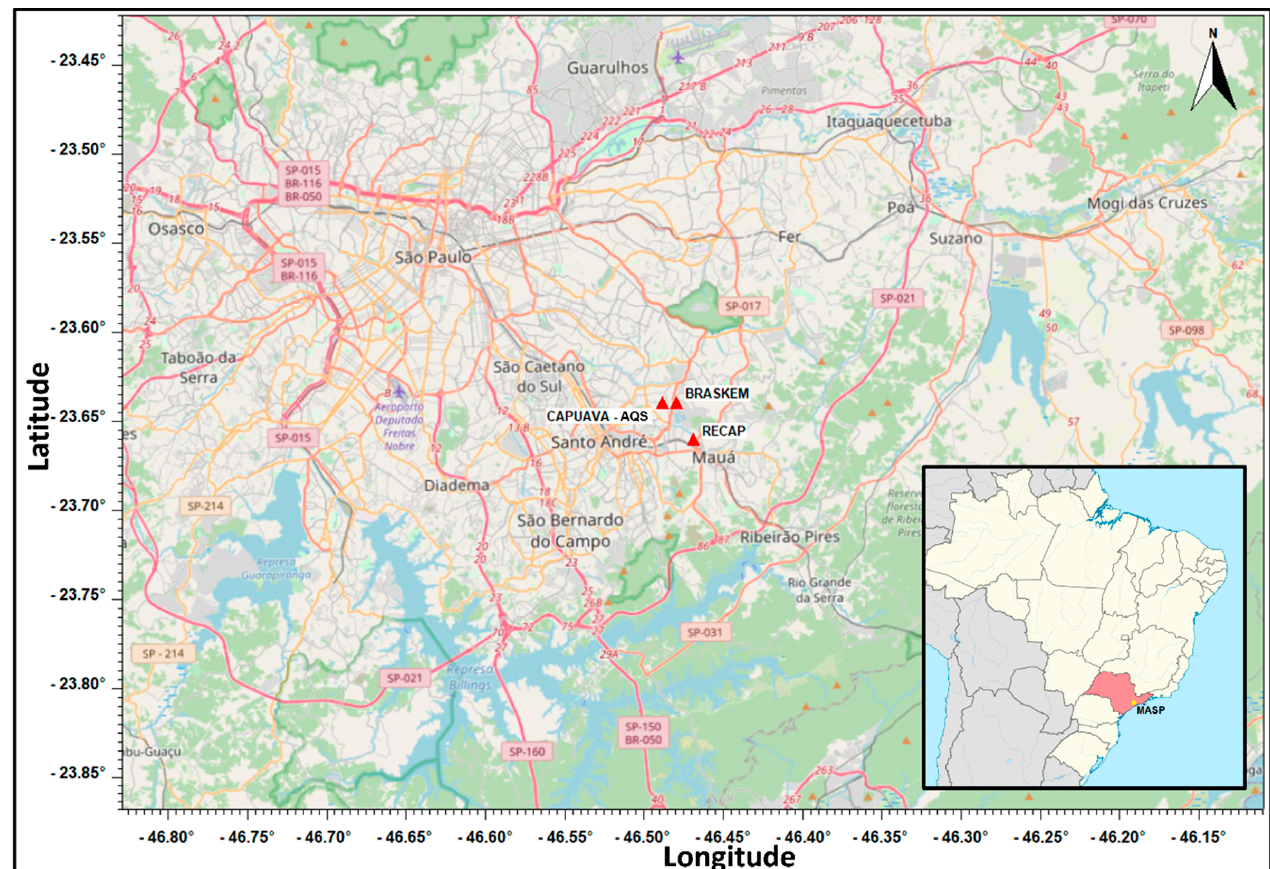
Figure 1. Metropolitan area of São Paulo (MASP) with Braskem and RECAP industries, and the CETESB, Capuava Air Quality Station, and AQS (identified by the red triangles). Source: OpenStreetMap.